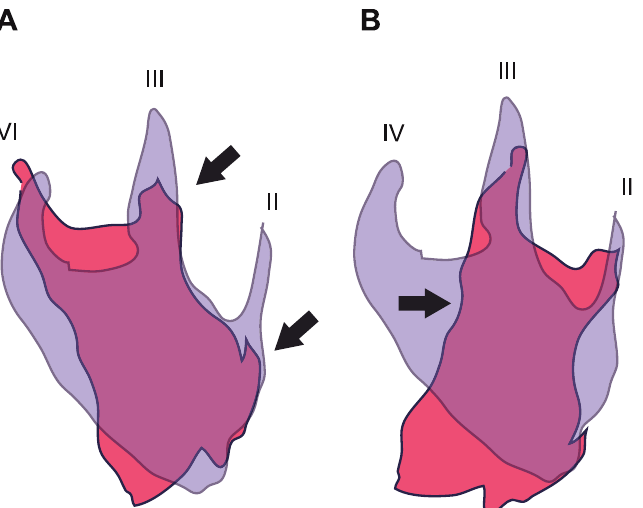
Fig 9. Hypotheses on left footprint deformation. Superimposition of left (red) and right (violet) footprints. The violet contour has been horizontally rotated, for a same digit comparison. The arrows mark the main features that should be considered to interpret the deformation (see text). (A) Digit II damaged is the preferred hypothesis. (B) Loss of digit